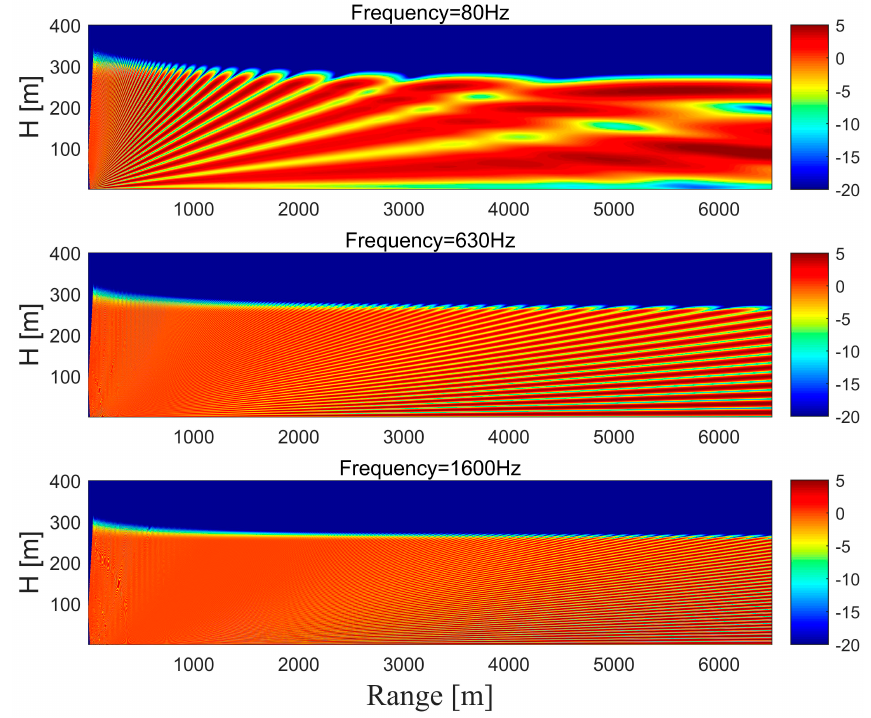
Figure 10. Relative sound pressure level at different frequencies.